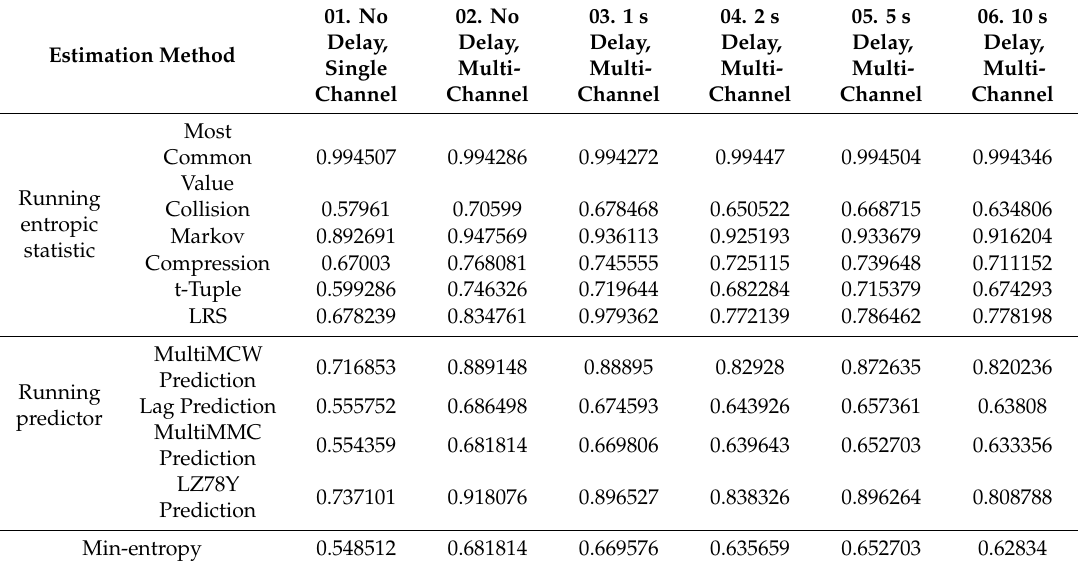
Table 3. Entropy comparison result of the WAV file format generated from radio signals collected under all